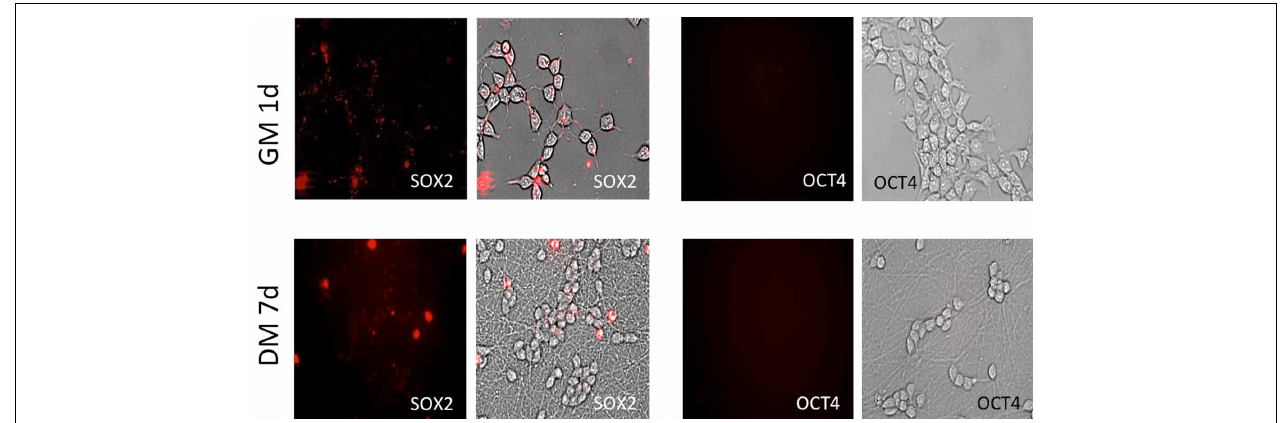
FIGURE 1 | Fluorescent images of cells transfected with MBs targeting stem cell markers SOX2 and OCT4 . High transfection eficiency was detected using SLO and ∼ 95% of cells shows to be positive for SOX2 MB after 1 d in GM. Relatively the same